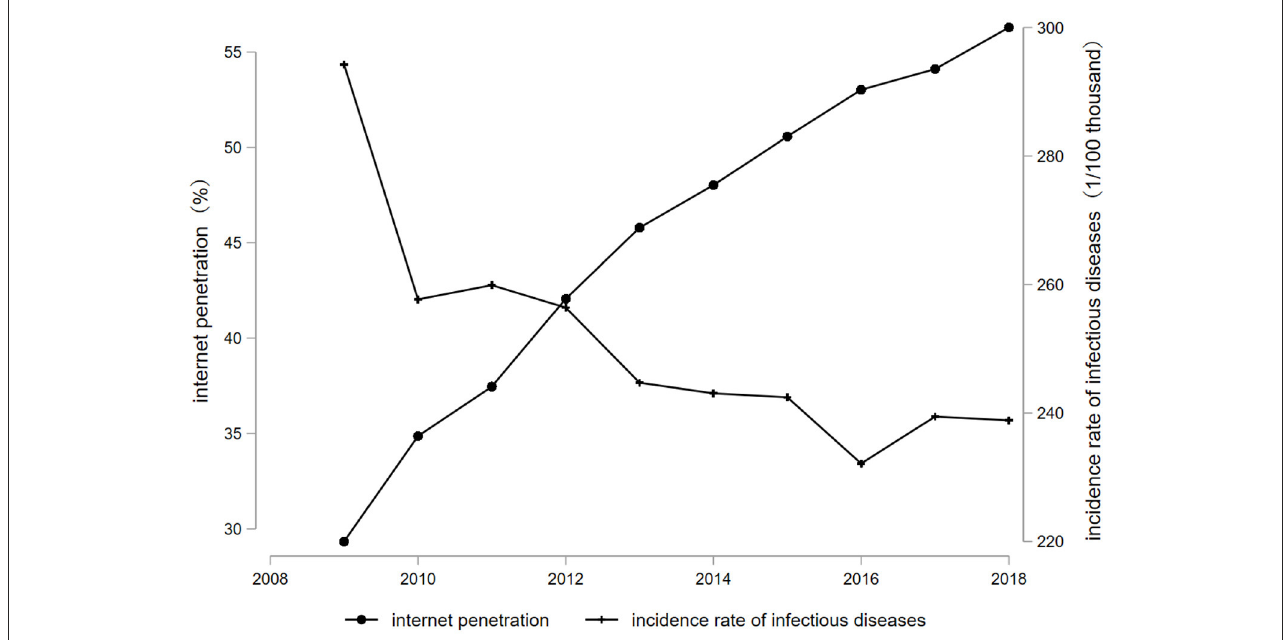
FIGURE1 Internet penetration and changes in the incidence of infectious diseases, 2009–2018.